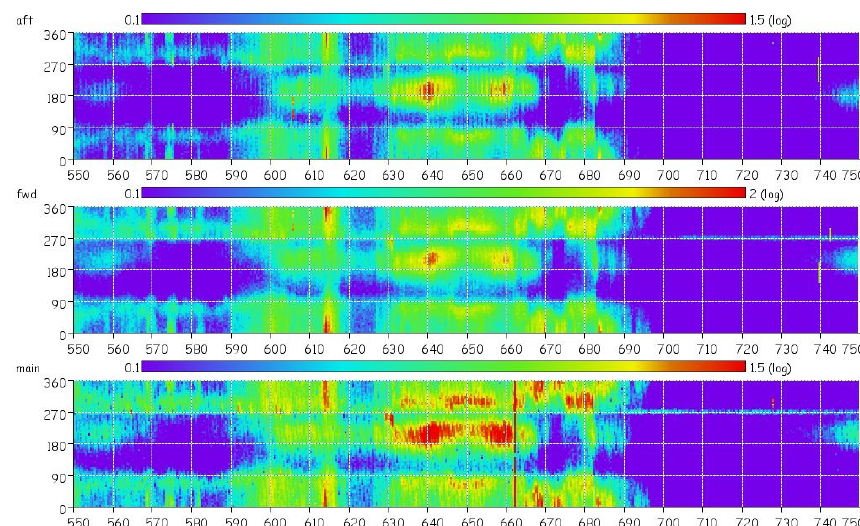
Fig. 5. Pitch angle spectrograms [deg] of 6eV ions as seen on the 3 separated payloads, as a function of time [s] from T+550s to T+750s. (Color bar proportional to differential energy flux eV/cm 2 /s/sr/eV, arbitrary gain.)